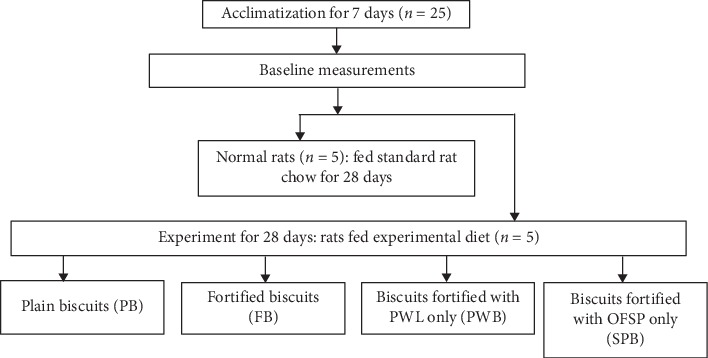
Experimental groups.